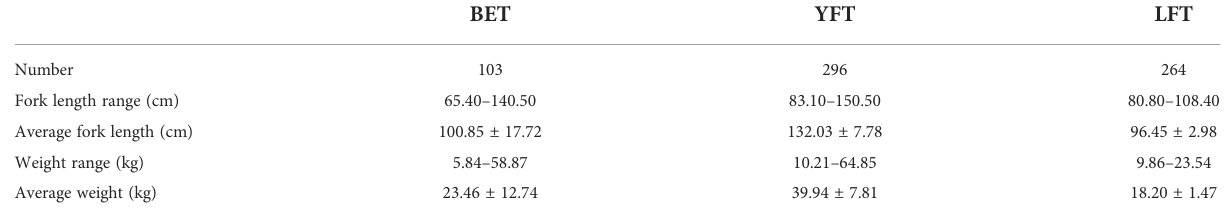
TABLE 1 Biological data for three species of tuna.